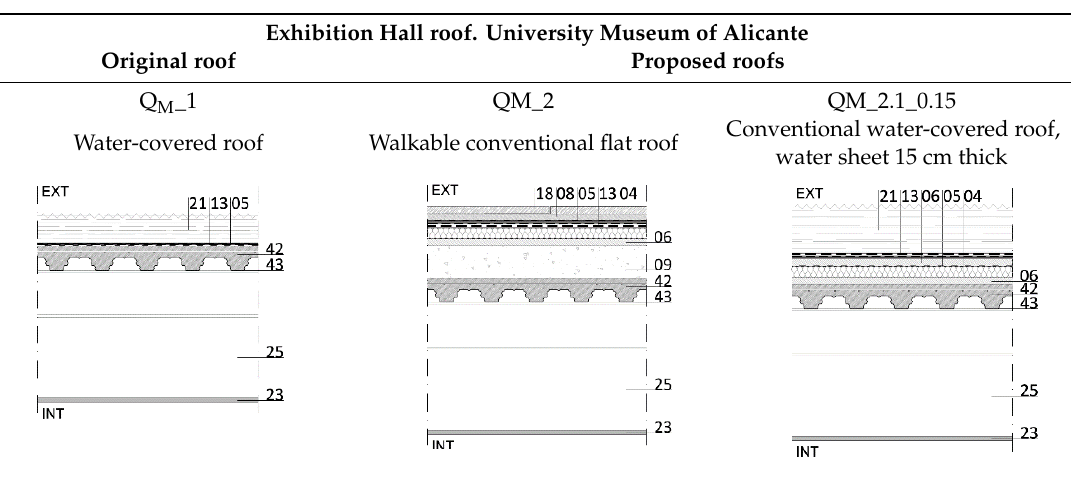
Table 7. Thermal properties of the materials that the roofs are built with thermal conductivity ( λ ), density ( ρ ) and specific heat capacity ( c p